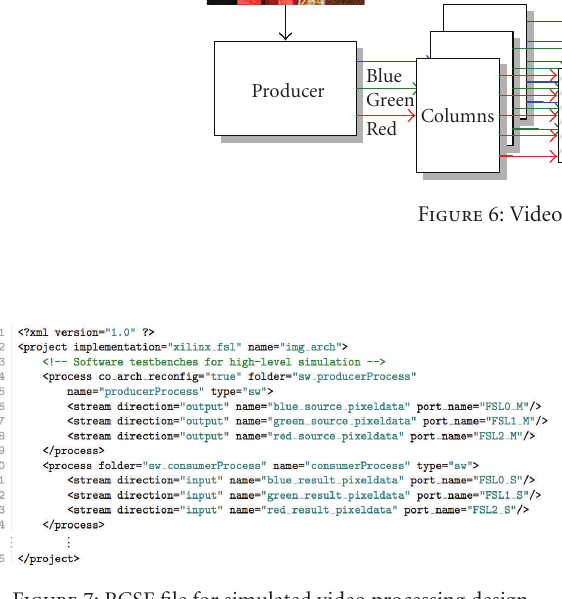
Figure 7: RCSF file for simulated video processing design.